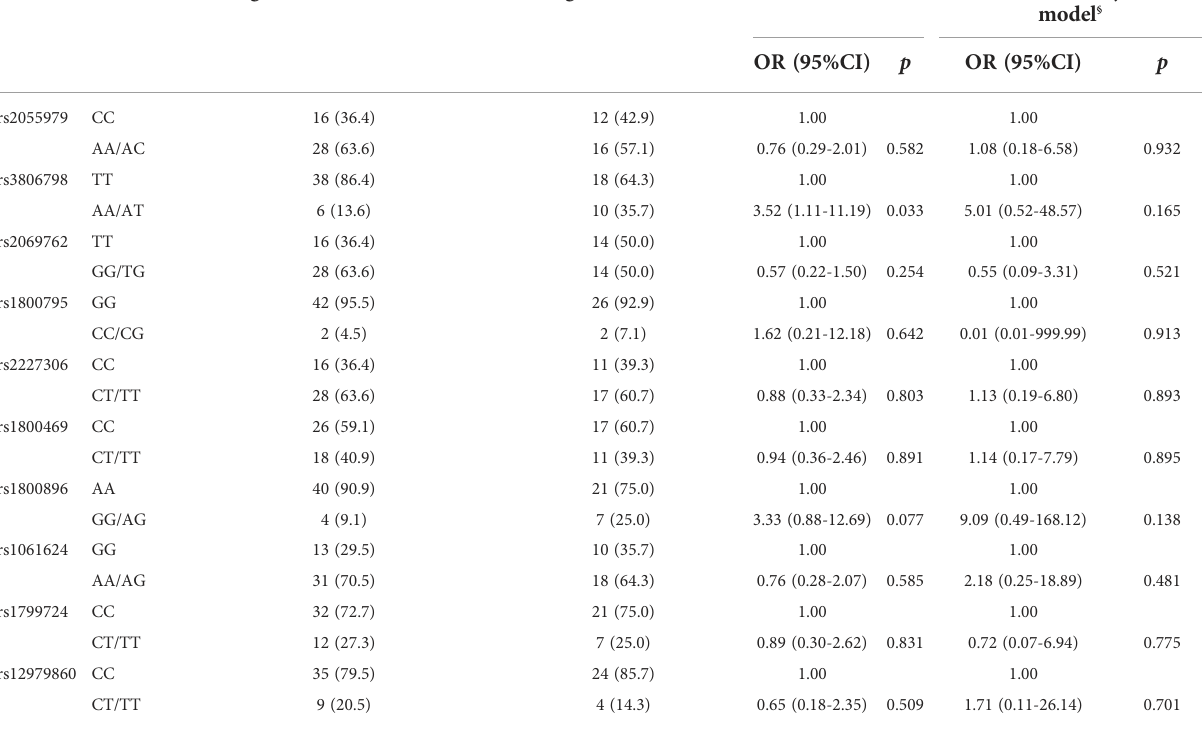
TABLE 4 Association between SNPs in relation to cytokines and HBsAg